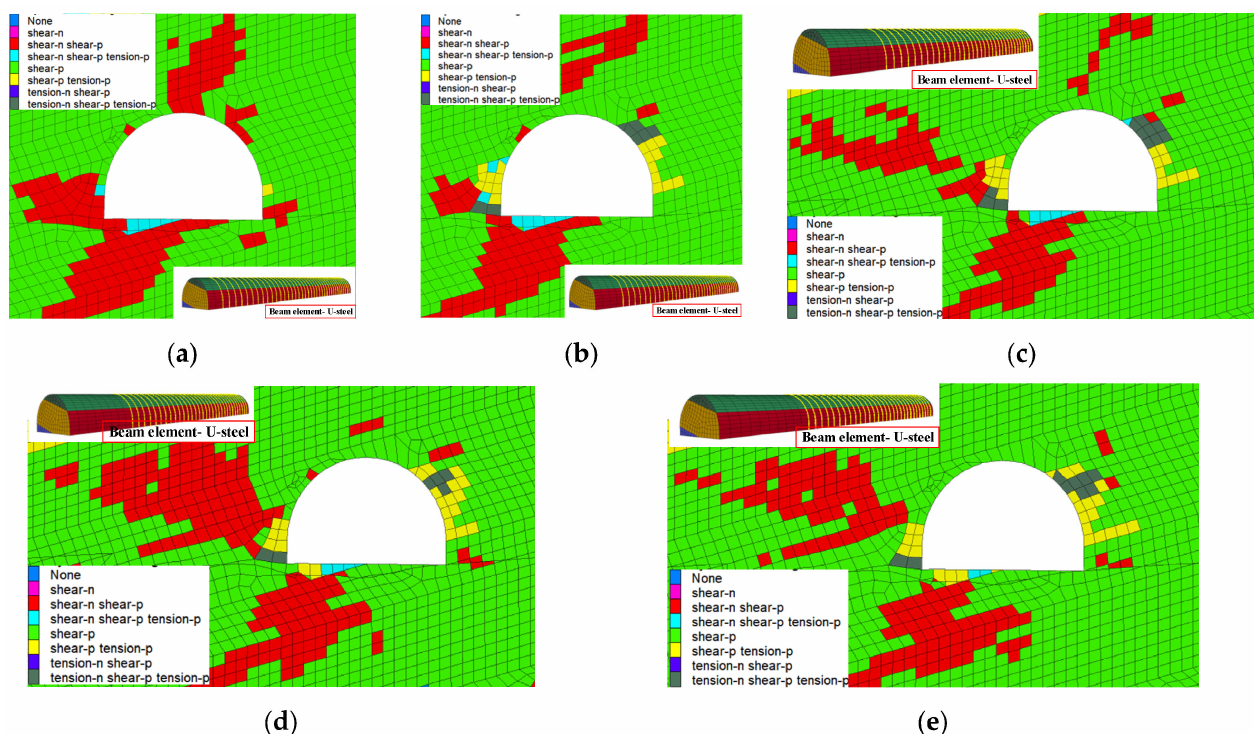
Figure 10. Development and distribution of a roadway plastic zone under different URDs. ( a ) Plastic zone at a URD of 2 m. ( b ) Plastic zone at a URD of 4 m. ( c ) Plastic zone at a URD of 6 m. ( d ) Plastic zone at a URD of 8 m. ( e ) Plastic zone at a URD of 10